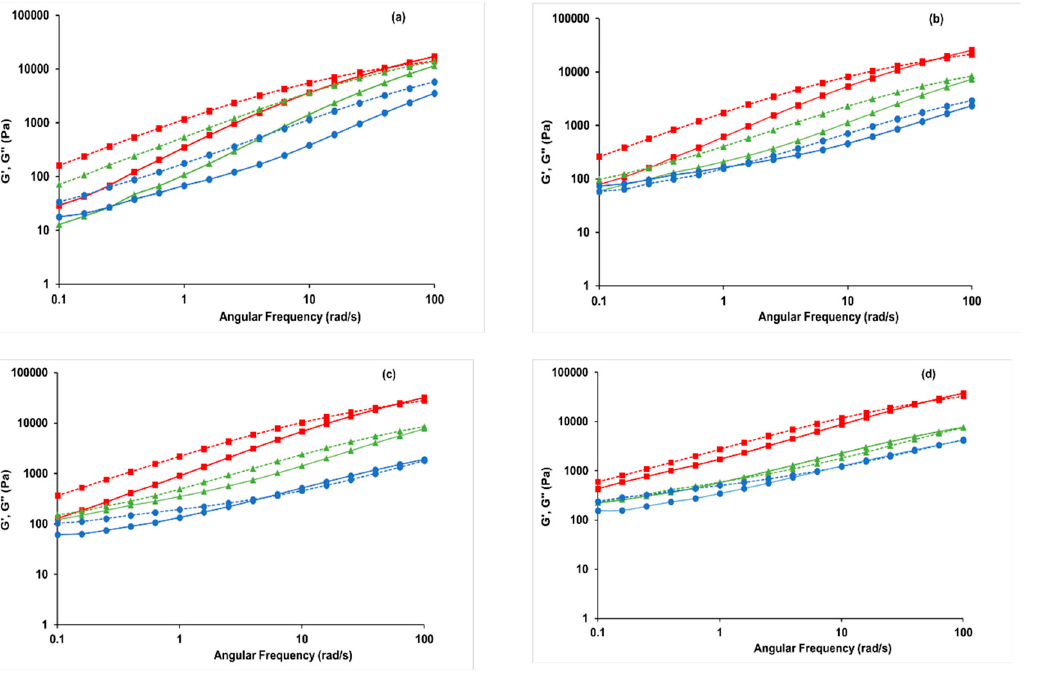
Figure A1. Storage modulus (G’) and loss modulus (G ′′ ) of ( a ) PAN; ( b ) PAN-10%BL; ( c ) PAN-20%BL; and ( d ) PAN-30%BL blends as a function of angular frequency at different temperatures. ■ —150 °C; ▲ —180 °C; ● —200 °C; ▬ G’; ▪▪▪ G ′′ .